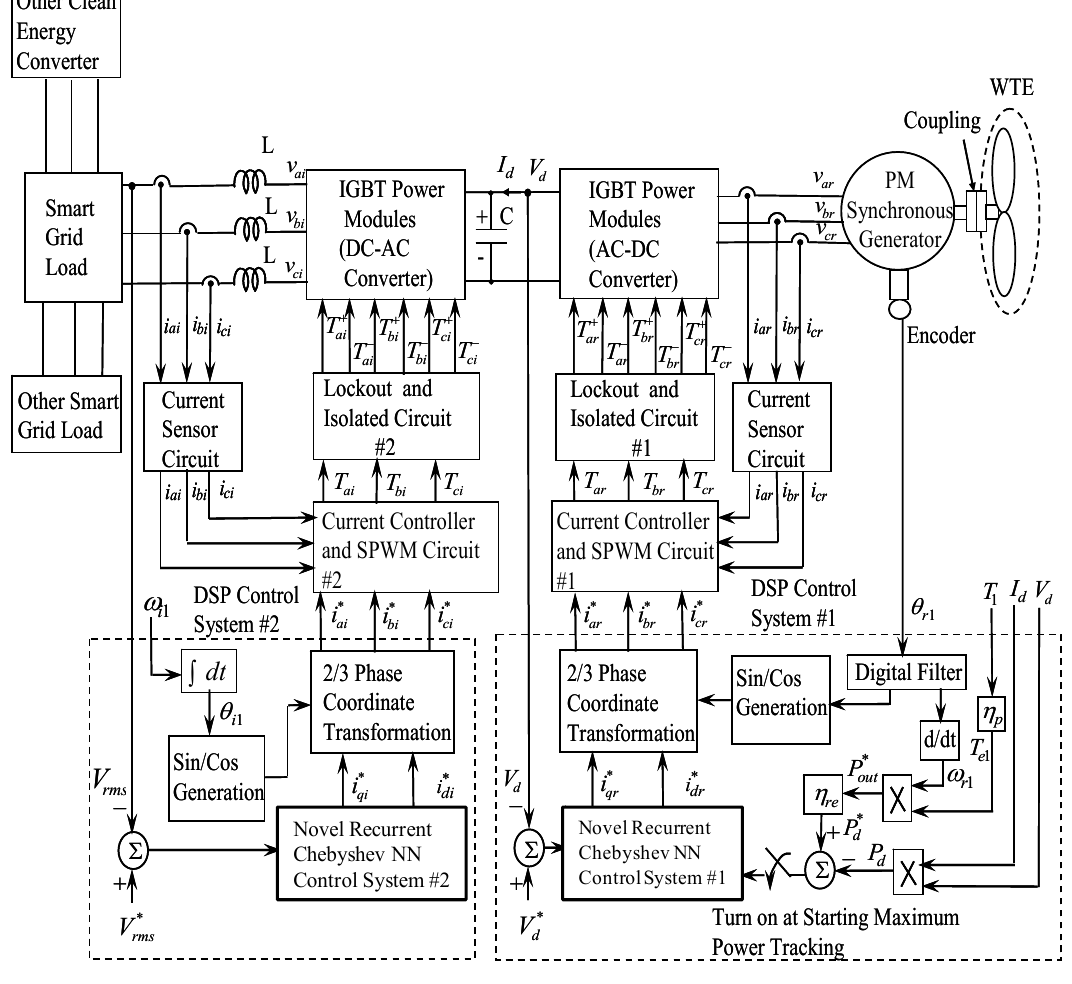
Figure 3. System configuration of the WT driving a PM synchronous generator system through AC-DC converter and a DC-AC converter using two sets of novel recurrent Chebyshev NN control